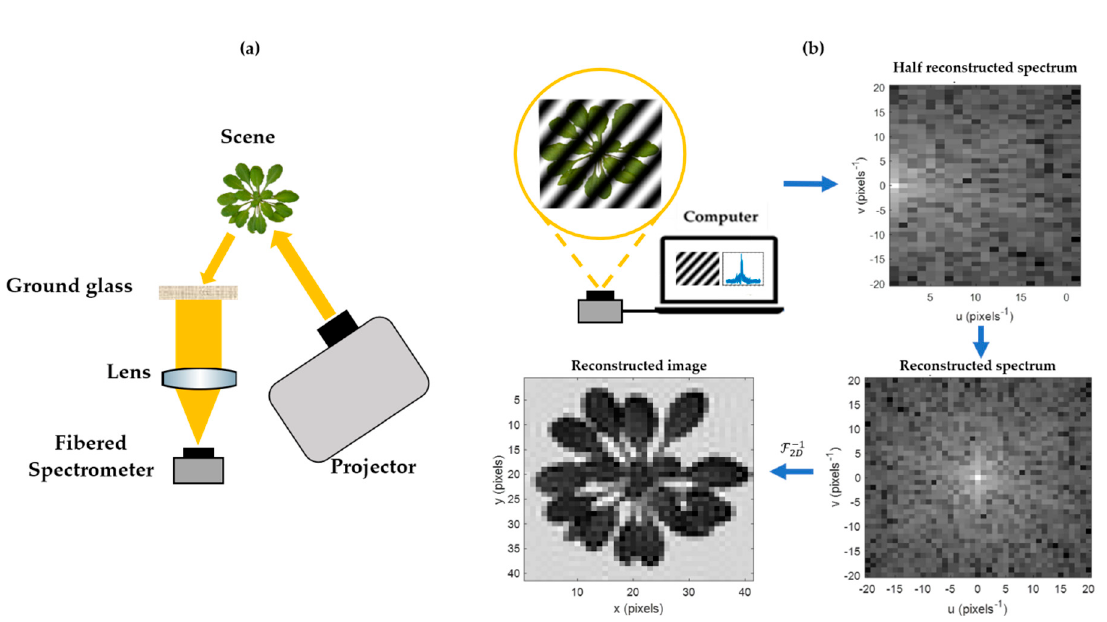
Figure 1. Hyperspectral single pixel imaging (HSPI) acquisition and reconstruction methods in the reflectance and experimental setup. ( a ) Experimental HSPI setup, consisting of a commercial video projector displaying Fourier patterns onto a scene and a lens focusing the reflected optical flow on a detection part. Detection was performed by a general-purpose fibered spectrometer for spectrally sampling acquisitions. ( b ) Simulation of a Fourier-based single pixel imaging acquisition with a resolution of 41 × 41 pixels.